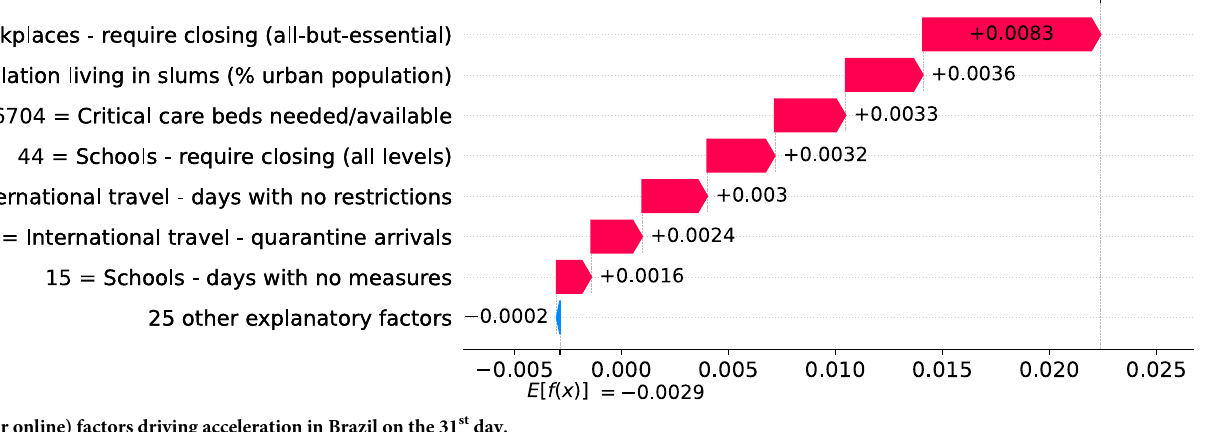
Fig 28. (Color online) factors driving acceleration in Brazil on the 31 st